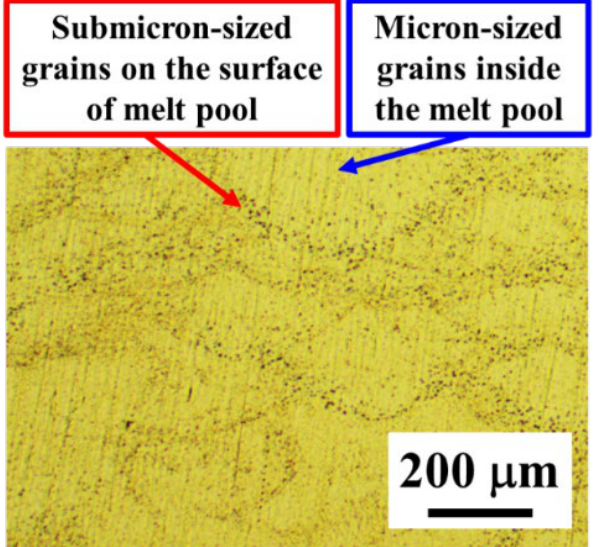
Figure 5. Optical microscope (OM) image of the etched sample, the TEM samples were prepared